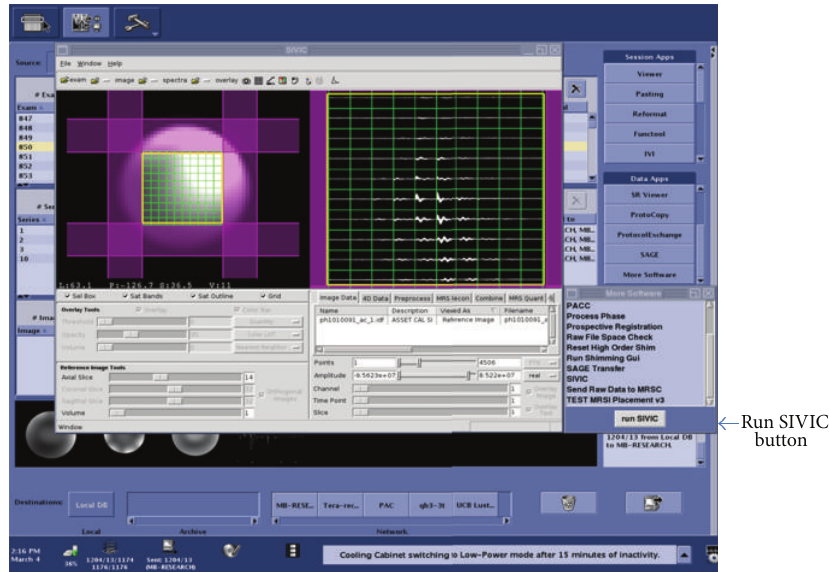
Figure 6: SIVIC GUI running on a GE 7T scanner console. Raw data from a phantom acquisition is shown in the right SIVIC panel. The left SIVIC panel shows the MRSI voxel grid spatially referenced to the reference image. The yellow box represents the PRESS volume localization, andpurpleregionsrepresentsatbands.TheSIVICGUIisconfiguredtorunfromconfigurablemenubuttonsonthescanner’soperatorconsole (right side).